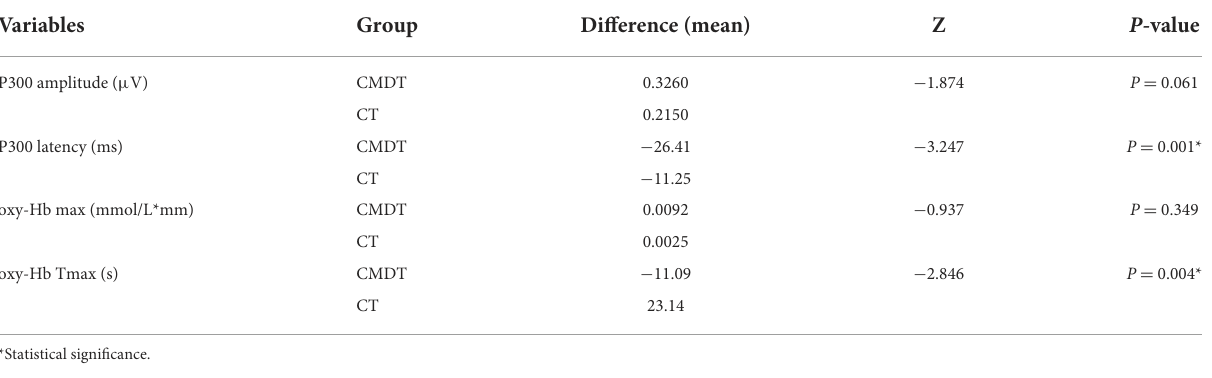
TABLE 3 Estimated mean change and statistical significance in secondary outcome variables.